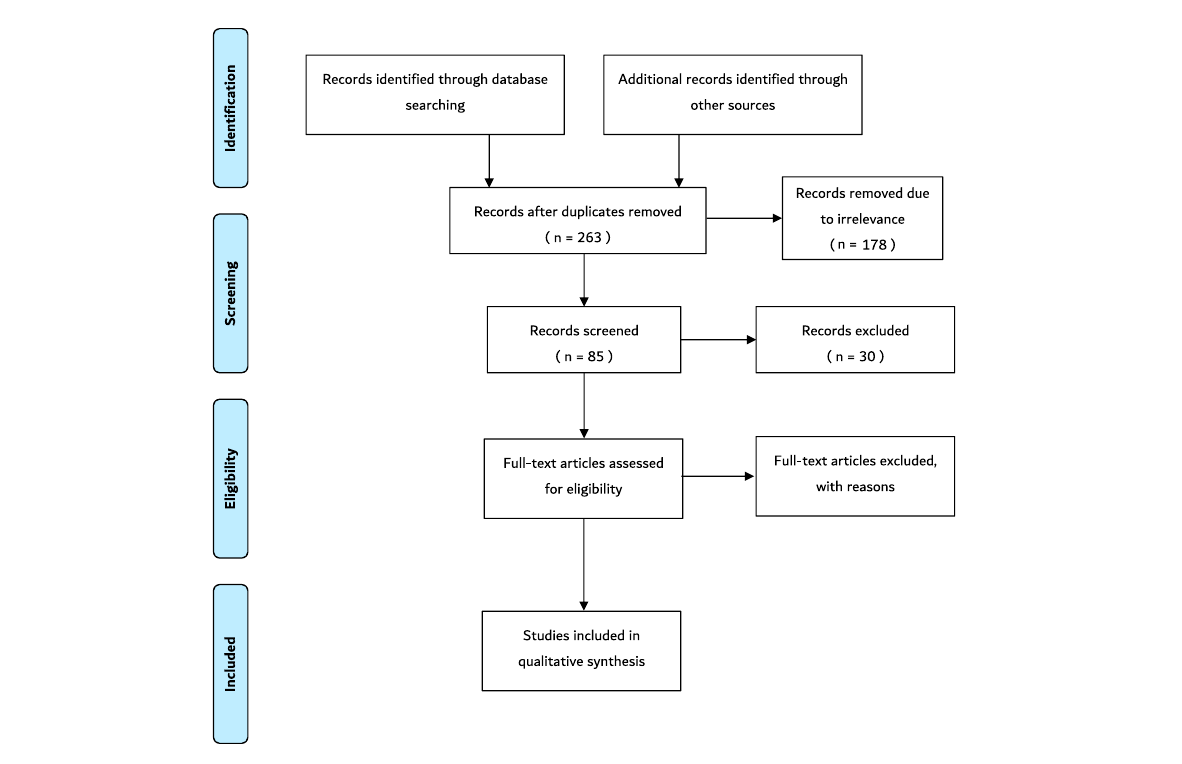
FIGURE 1 The schematic representation of the search method. Following the initial search, 273 records were retrieved. Ten duplicates were removed. Subsequently, 178 records were removed due to irrelevance after the titles were screened. Thereafter, 30 records were excluded due to the irrelevance of the abstracts. Finally, 34 full-text articles were removed because some did not satisfy the inclusion criteria and the others were not original articles. Thus, 21 articles that satis fi ed the inclusion criteria were included in the study. N =